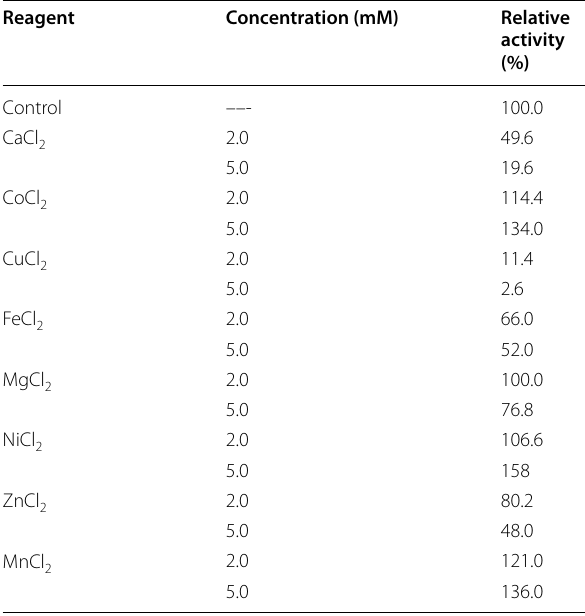
Table 2 Effect of divalent cations on the purified TLGST Reagent